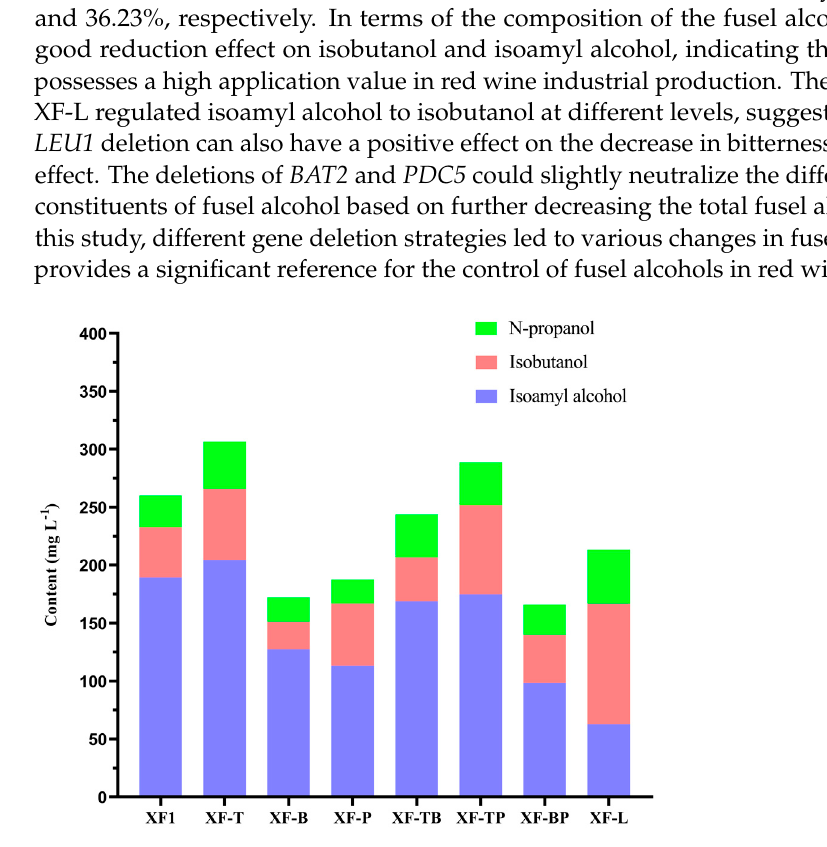
Figure 4. Content of total fusel alcohols in the recombinant strains and wild-type strain